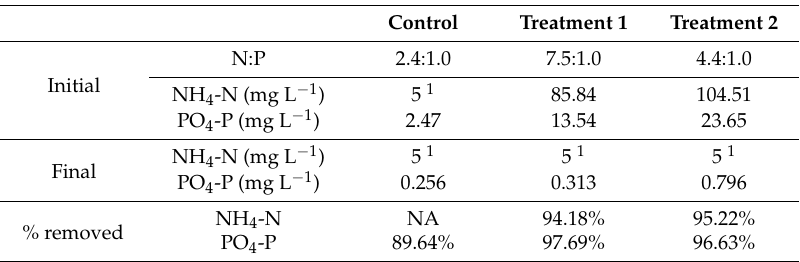
Table 2. Characteristics of growth media before (initial) and after (final) the 12-day growth period of C. vulgaris.